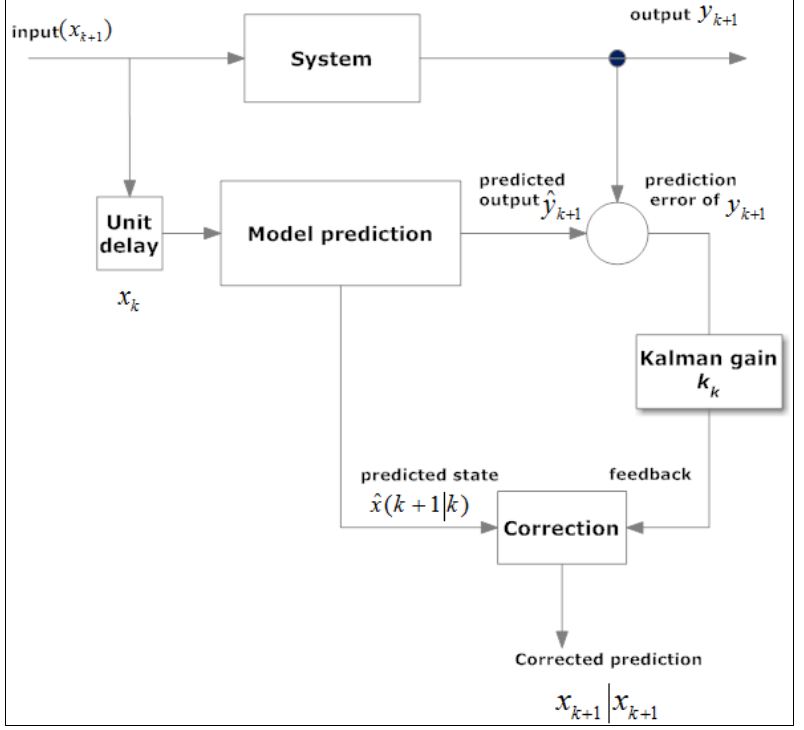
Figure 3. System block diagram of Extended Kalman Filter (EKF).